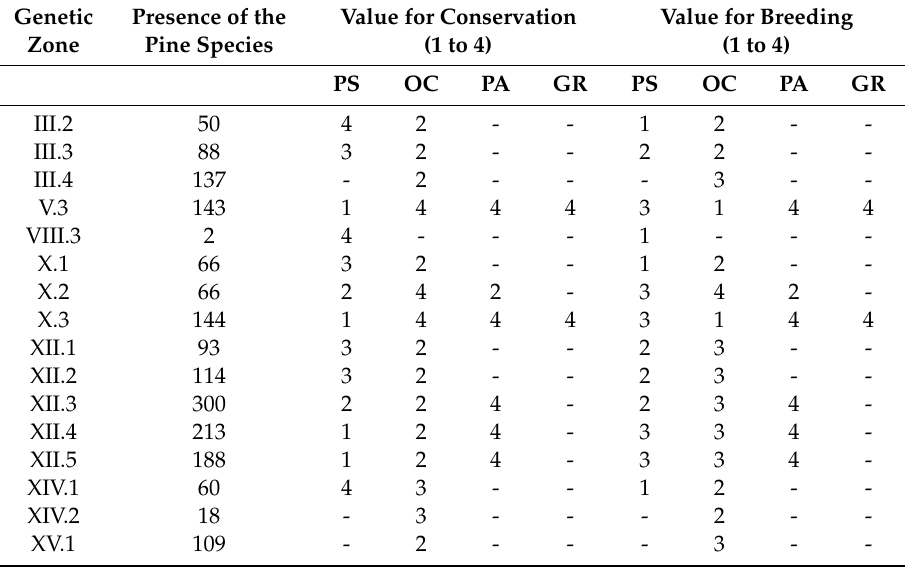
Table 4. Importance for conservation and use of forest genetic resources by genetic zone and species (PS: P. pseudsotrobus , OC: P. oocarpa , PA: P. patula , GR: P. greggii